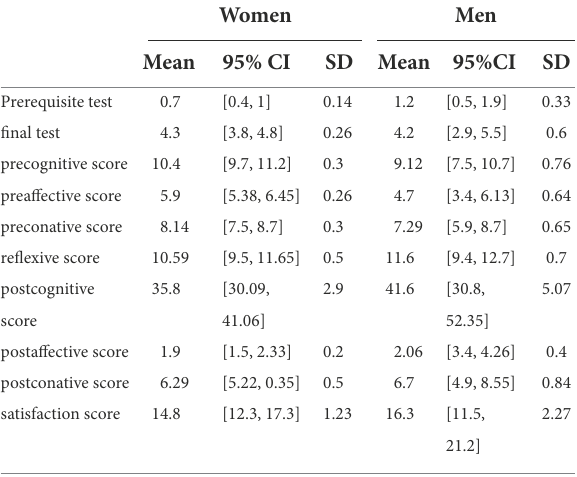
TABLE 4 variation of the different scores according to the students’ level and gender. Variation according Variation according to to the students’ levels the students’ gender F Significance